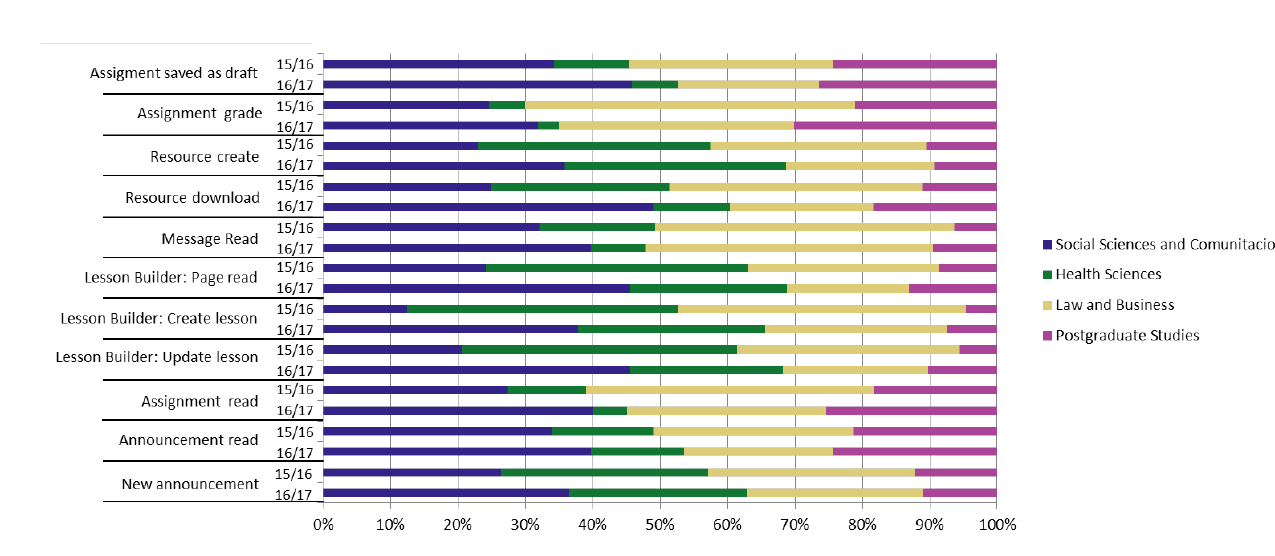
Figure 4. Ranking of events per lecturer (in percentage) related to the blended modality for the academic years 2015/16 and 2016/17. Note that only faculties with blended degrees are shown.